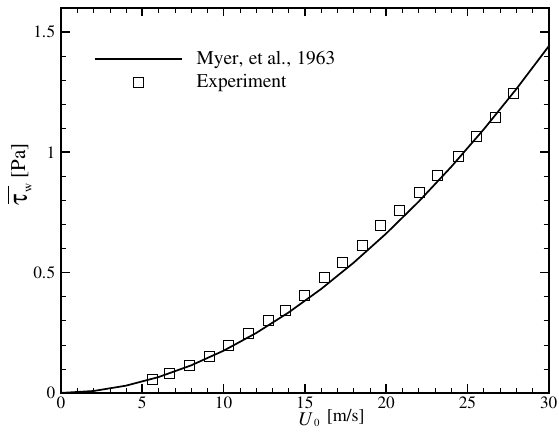
Fig. 13 Wall shear stress (cid:28) w measured by the Preston tube at x / d =